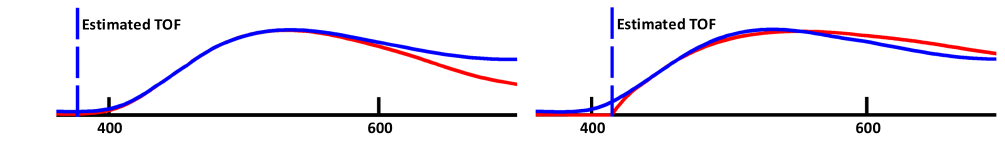
Figure 11. Curve-fitting results of the GN model and the DE model. ( Left ): NRLM algorithm with the GN model; ( Right ): NRLM algorithm with the DE model. (Blue line: original echo signal; red line: envelope model by the proposed